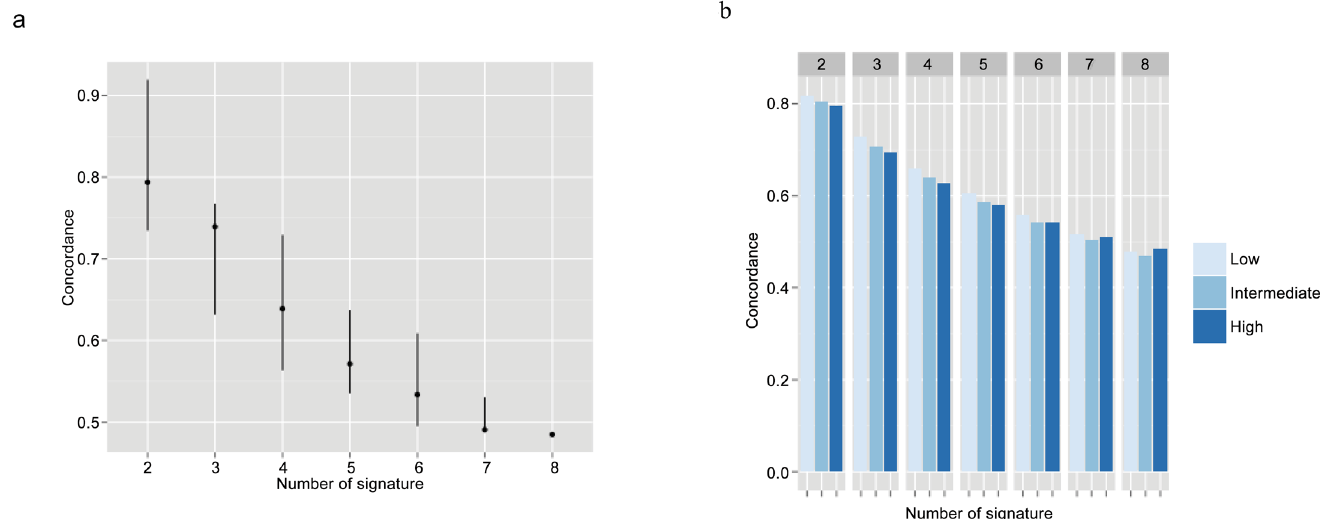
Fig 4. Concordance of the prediction with molecular signatures combination. Combination of 2 to 7 molecular signatures. (A)Overall population (B) NPI risk groups.